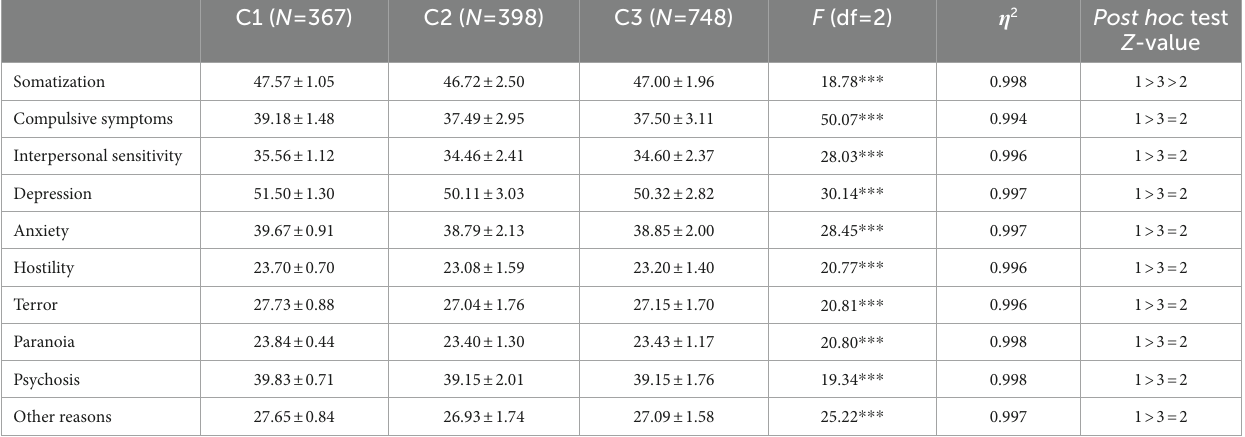
TABLE 5 Descriptive data and test of variance (M ± SD) for the three groups of subjects on mental